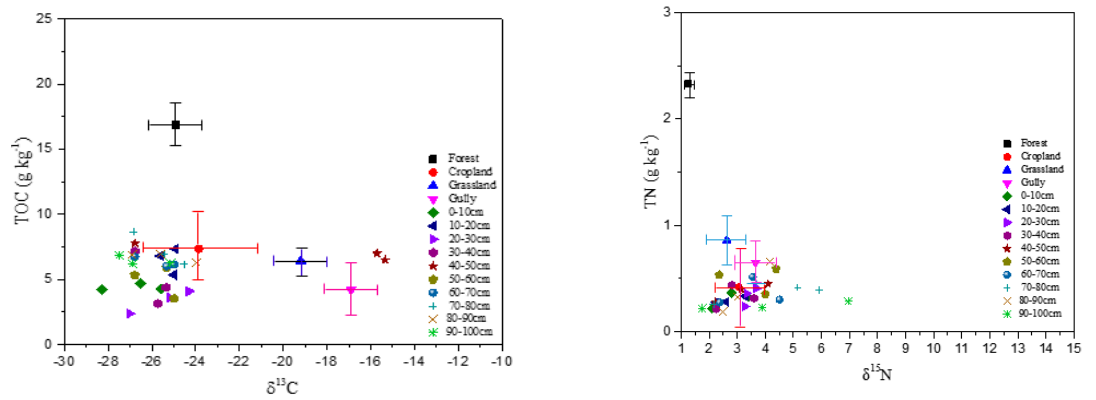
Figure 5. Correlations of TOC vs. δ 13 C and TN vs. δ 15 N in the source soils and sediments (Horizontal and vertical bars denote 95% confidence